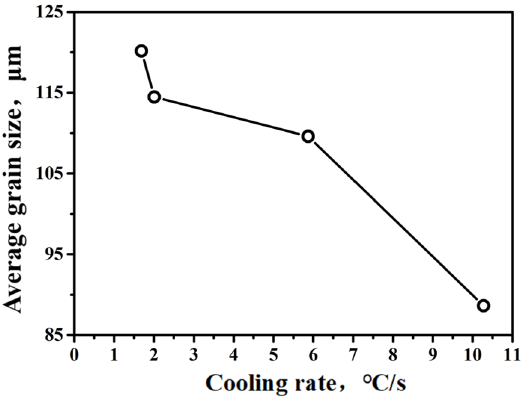
Figure 9. Effect of cooling rate on average grain size of austenite phase.